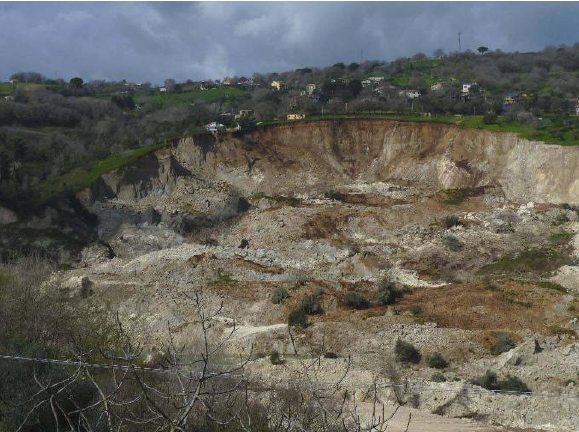
Figure 1. The crown of the Maierato Landslide The landslide of Maierato (figure 1) occurred on February 15th 2010; it is located west of the town and its crown has a width of about 500 m, while the whole length is of about 1400 m. On